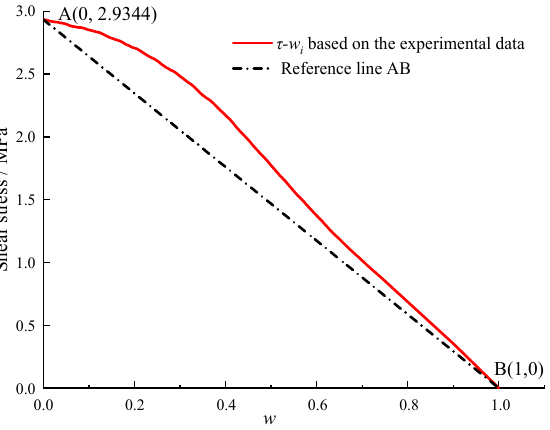
Figure 8. τ - w i based on the experimental data and the reference line.